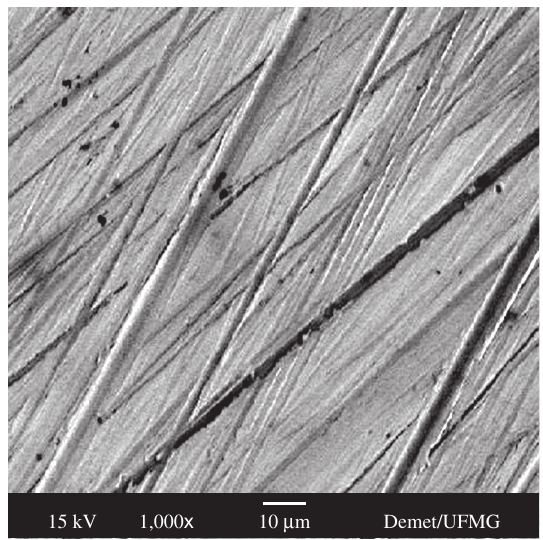
Figure 10. SEM micrograph of obtained SiO substrate at 200